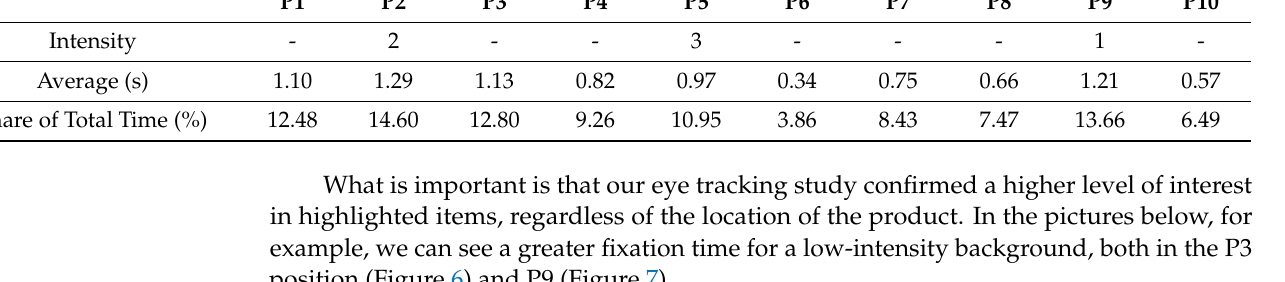
Table 2. Fixation times in the second category with background highlights. Source: own elaboration.